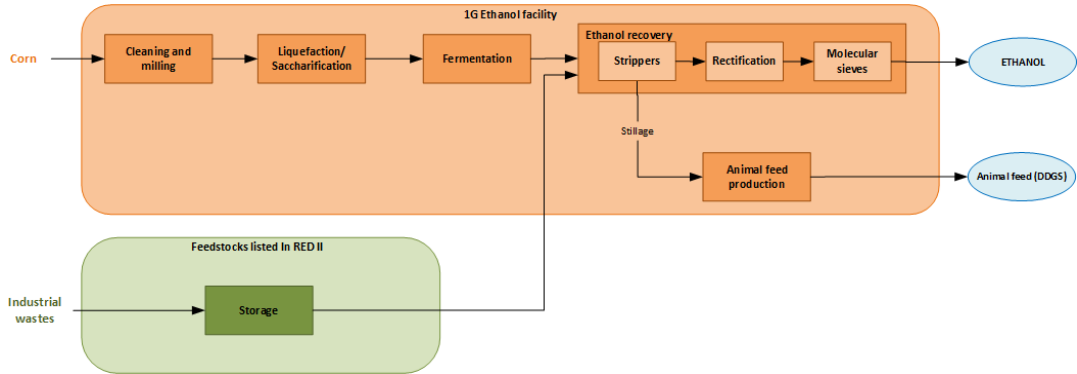
Figure 7. Descriptive flow sheet of the scenario 1.